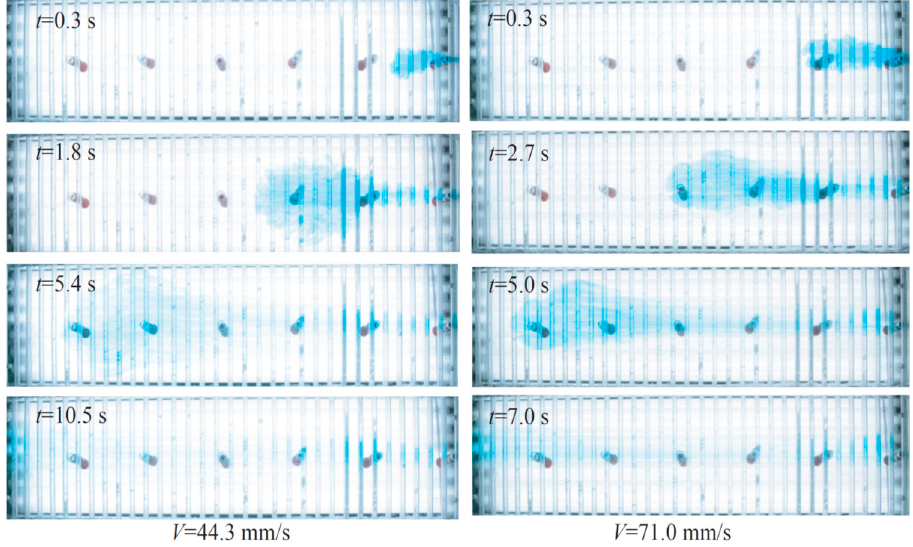
Figure 4. Solute plume of the tracer test in rough single fractures with rectangular roughness.